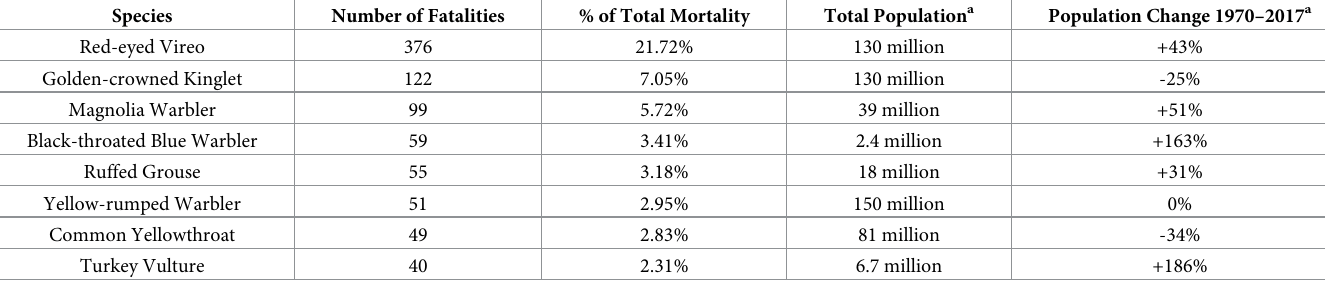
Table 3. Eight most frequent species of bird mortality at wind turbines in the Northeastern US. Species Red-eyed Vireo